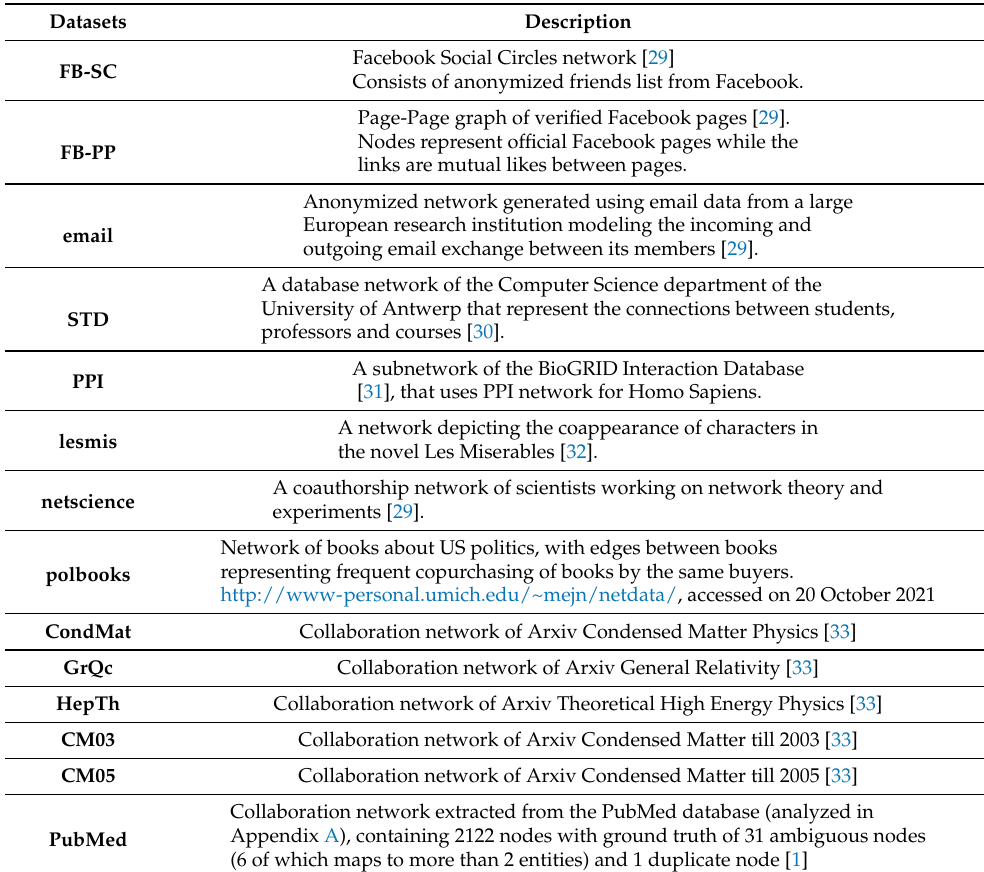
Table 1. The different datasets used in our experiments (Section 4.1).